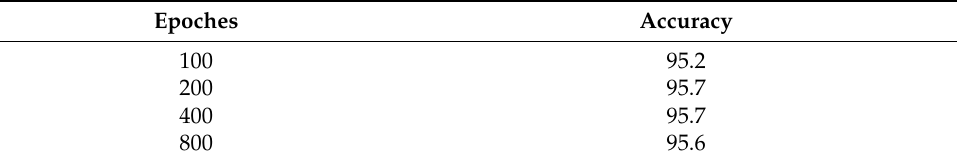
Table 8. Comparison of different pretraining